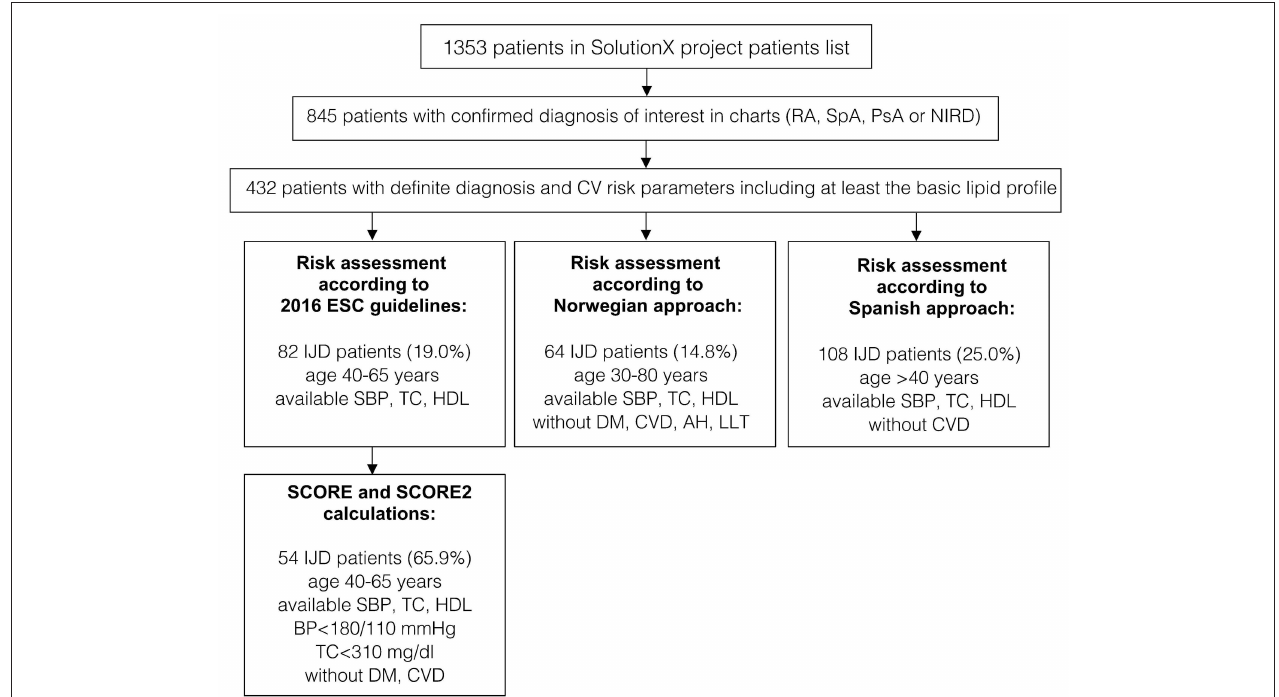
FIGURE 1 | A flow chart of patients’ selection and data availability for different analyses (original SCORE and SCORE 2 calculation, risk assessment according to 2016 ESC Guidelines, the Norwegian and the Spanish approaches). RA, rheumatoid arthritis; SpA, spondyloarthritis; PsA, psoriatic arthritis; IJD, inflammatory joint disease (aggregate of RA, SpA, and PsA); NIRD, non-inflammatory rheumatic disease; AH, arterial hypertension; CV, cardiovascular; CVD, cardiovascular disease; DM, diabetes mellitus; ESC, European Society of Cardiology; HDL, high density lipoprotein; LLT, lipid-lowering therapy; TC, total cholesterol; SBP, systolic blood pressure; BP, blood